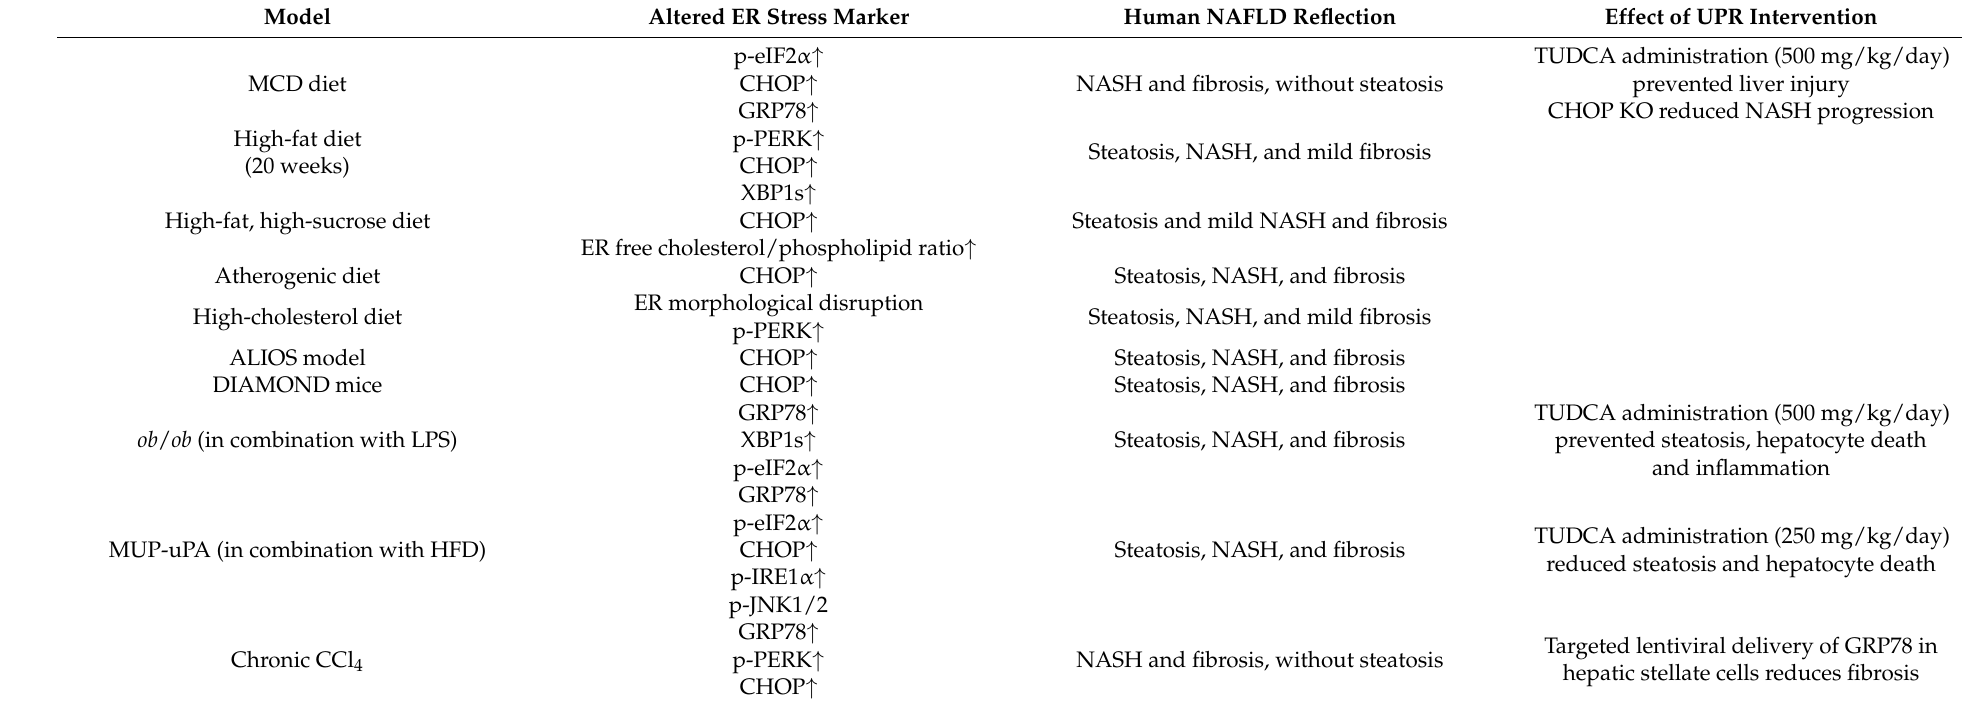
Table 1. Experimental nonalcoholic fatty liver disease (NAFLD) models with ER stress